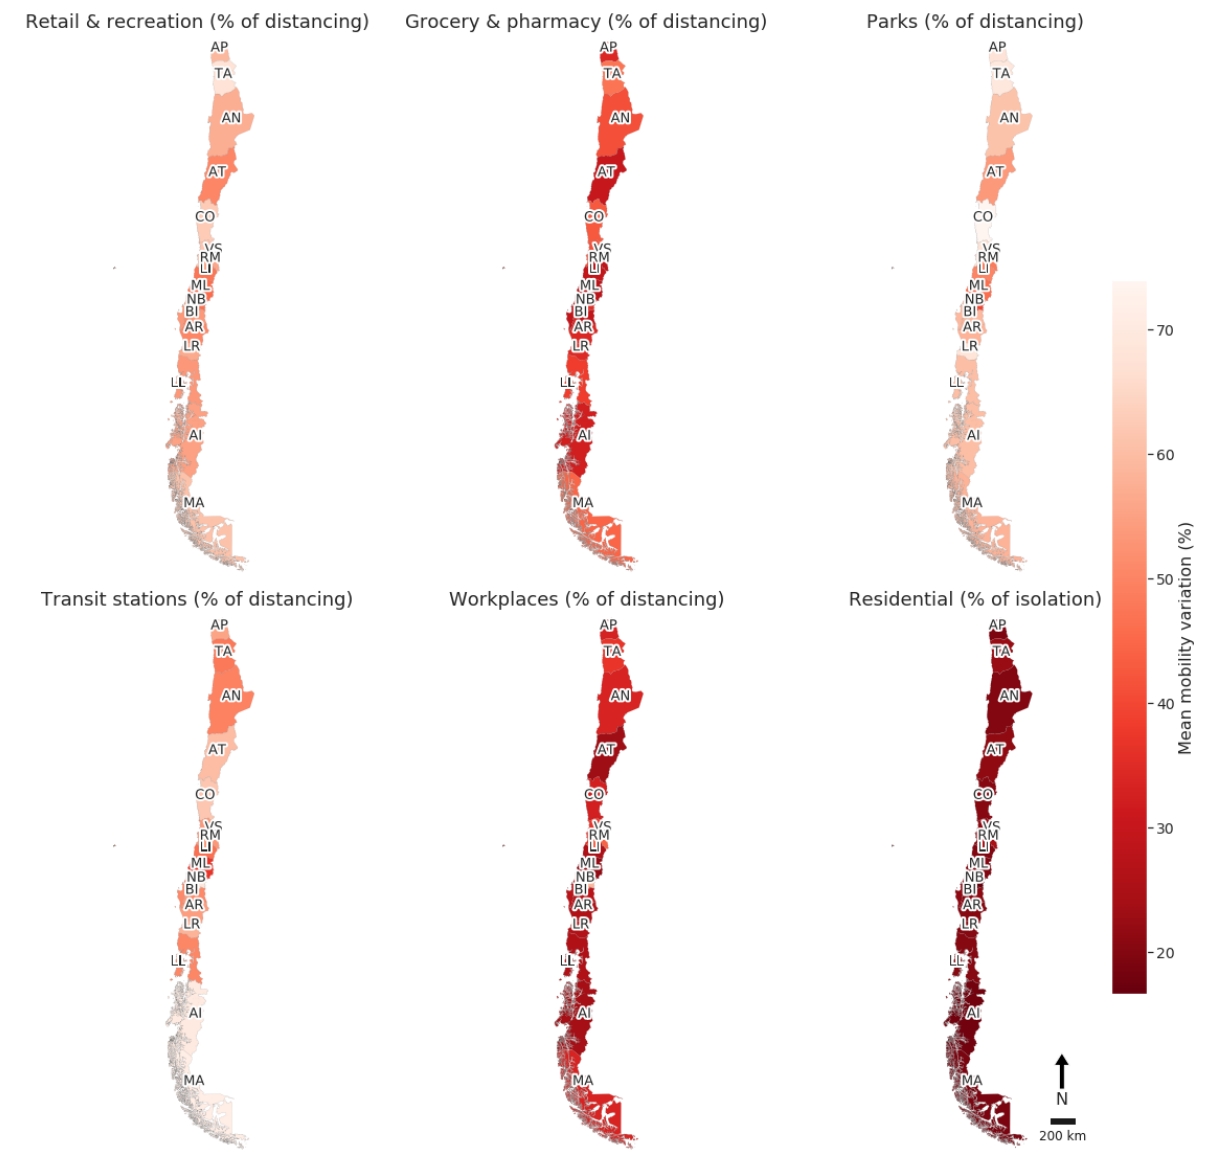
Figure 18. Average variation of mobility from baseline (3 January to 6 February 2020) for the regions of Chile during the period from 1 June to 27 October 2020. Lighter colours indicate greater distancing or greater isolation in residential areas. Source of basic data: Covid-19 Community Mobility Reports,